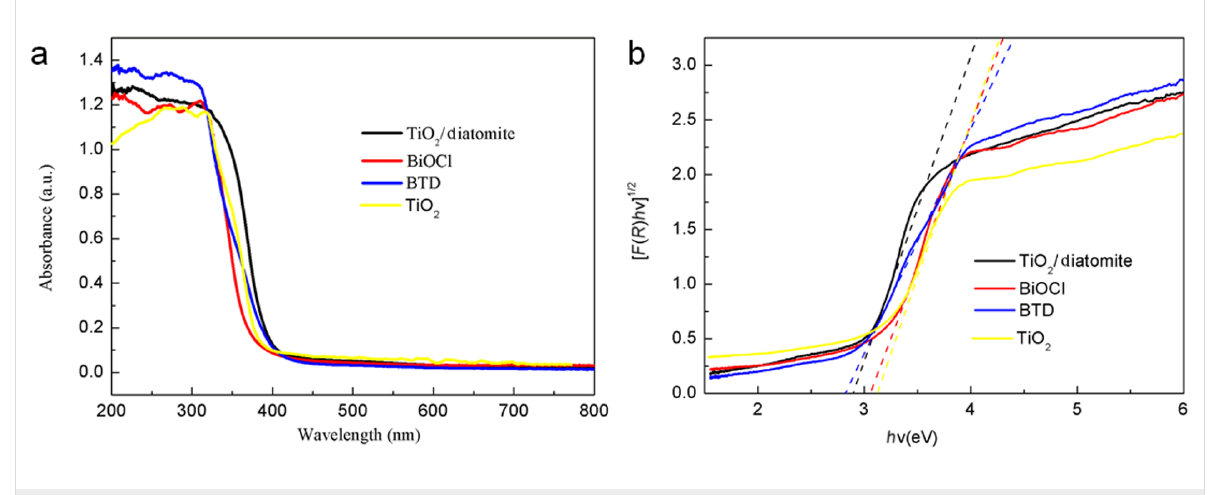
Figure 8: UV–vis absorption spectra (a) and band gap energy (b) of various samples.